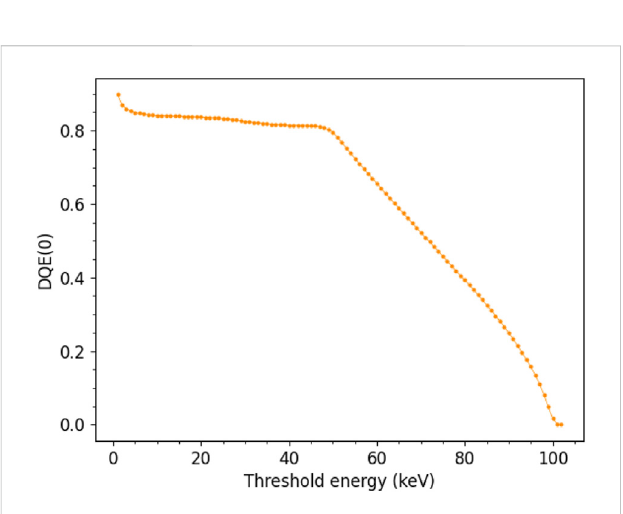
FIGURE 2 DQE (0) obtained from the event multiplicity distributions using Eq.